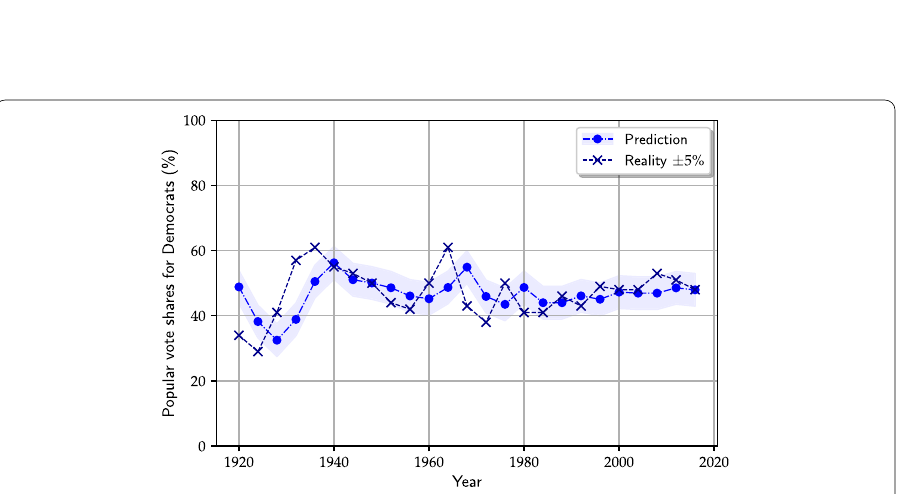
Fig. 5 Percentage of popular votes for Democrats in the US, prediction and reality. The shaded area covers a ± 5% deviation away from the predictions